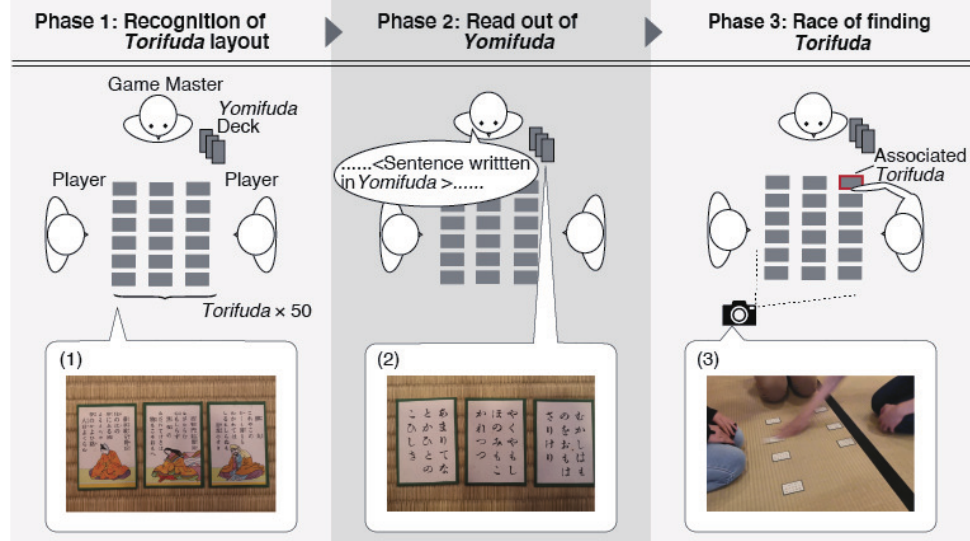
Figure 1. Uta-Karuta is a typical example of Karuta . Uta-Karuta consists of multiple cards divided into two sets: Torifuda and Yomifuda . Yomifuda and Torifuda exactly correspond to each other. ( 1 ) Torifuda : “grabbing cards” with pictures and/or written language, ( 2 ) Yomifuda : “reading cards” with written information, ( 3 ) The players position and cards placement during